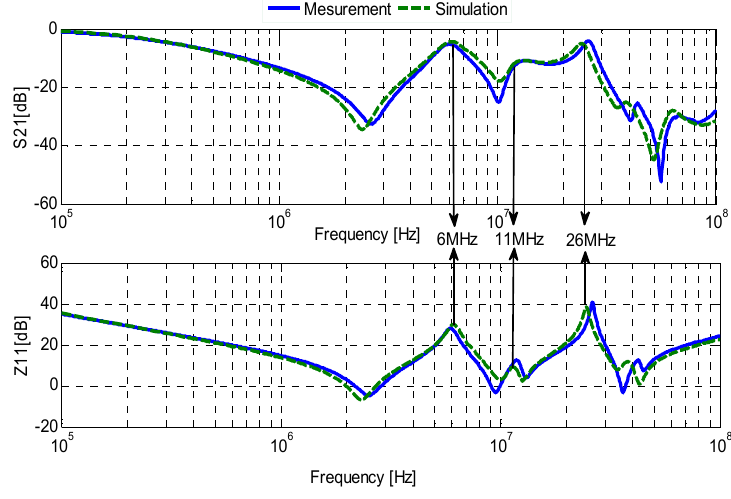
Figure 4. Magnitude of S21 and Z11.